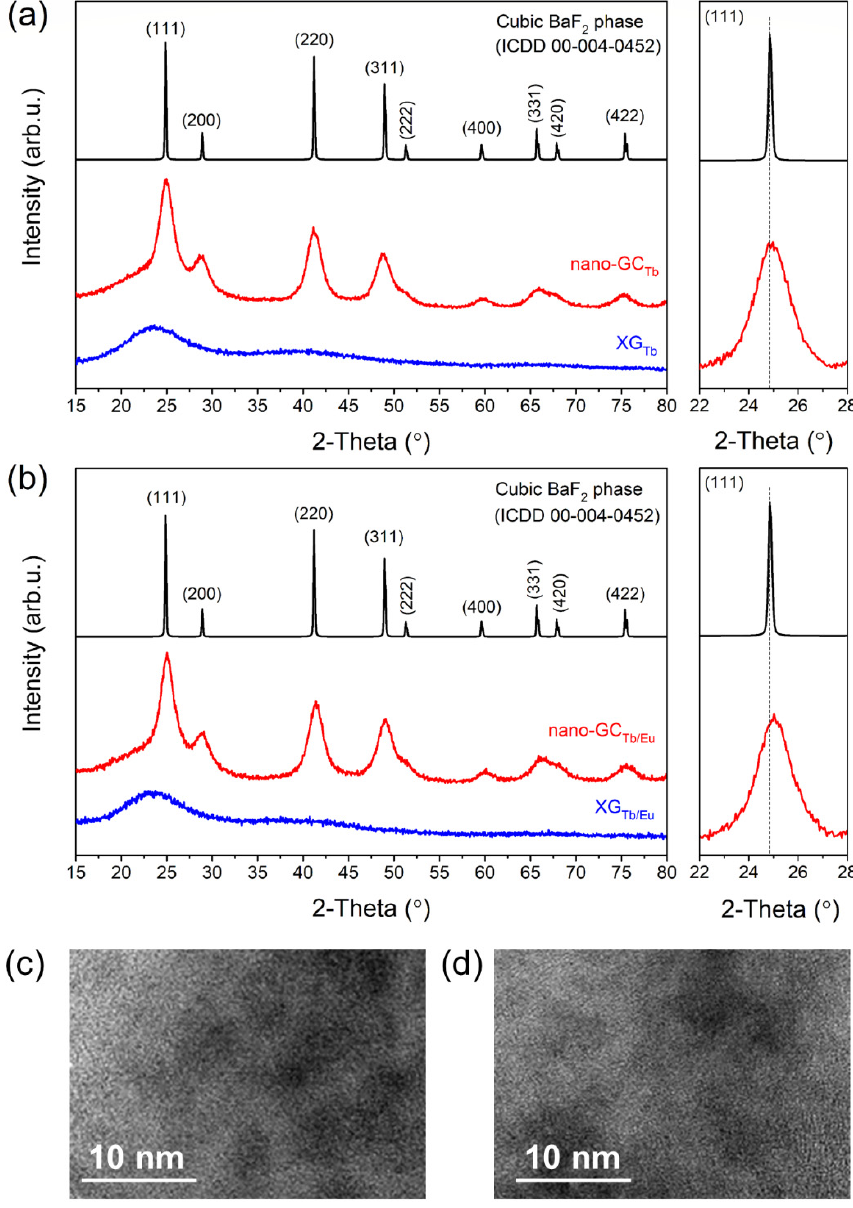
Figure 2. XRD patterns of prepared sol–gel samples: Tb 3+ singly doped materials ( a ) and Tb 3+ , Eu 3+ co-doped specimens ( b ). The standard data for the BaF 2 cubic phase (ICDD card no. 00-004-0452) are also shown for comparison. TEM images revealed the presence of fluoride crystals in glass-ceramics singly doped with Tb 3+ ( c ) and co-doped with Tb 3+ , Eu 3+ ( d ).